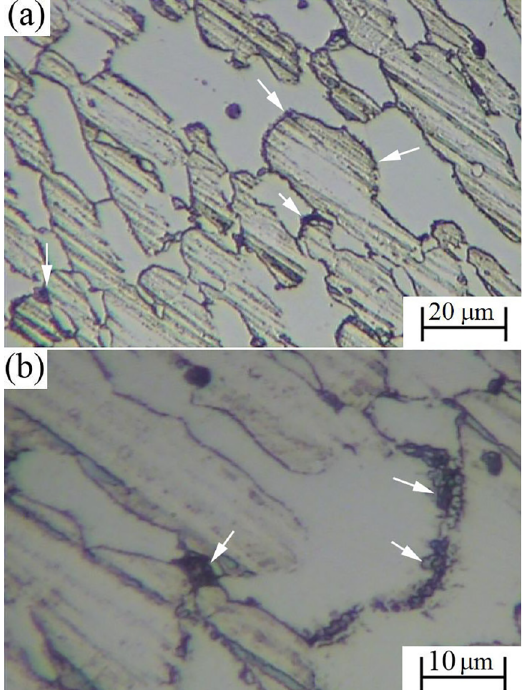
Figure 10. Qr/Qa ratios and deleterious phases precipitated percentage against aging time in SD-B samples aged at 800ºC till (a) 15 minutes and (b) 90